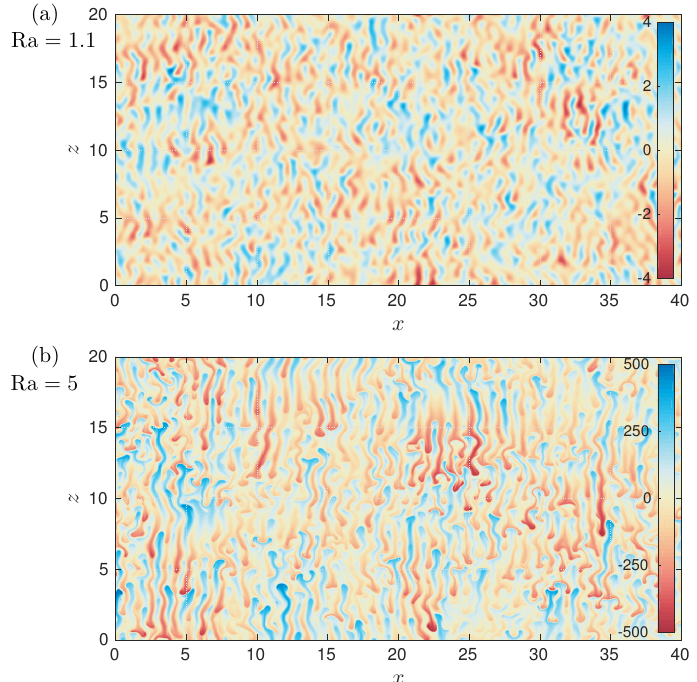
Figure 7. Snapshot of the salinity perturbation for Ra = 1.1 (top panel) and Ra = 5 (bottom panel).